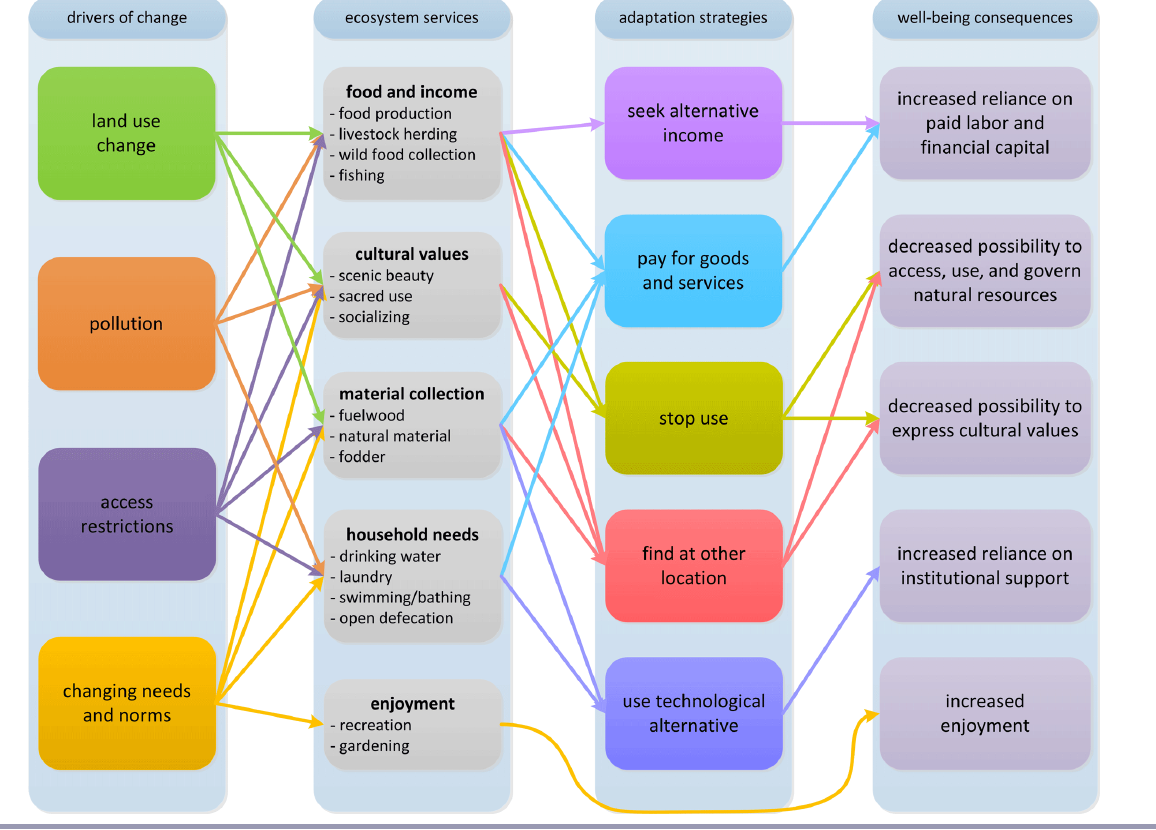
Fig. 7 . Diagram showing the links between drivers of change, ecosystem services, household adaptation strategies, and well-being